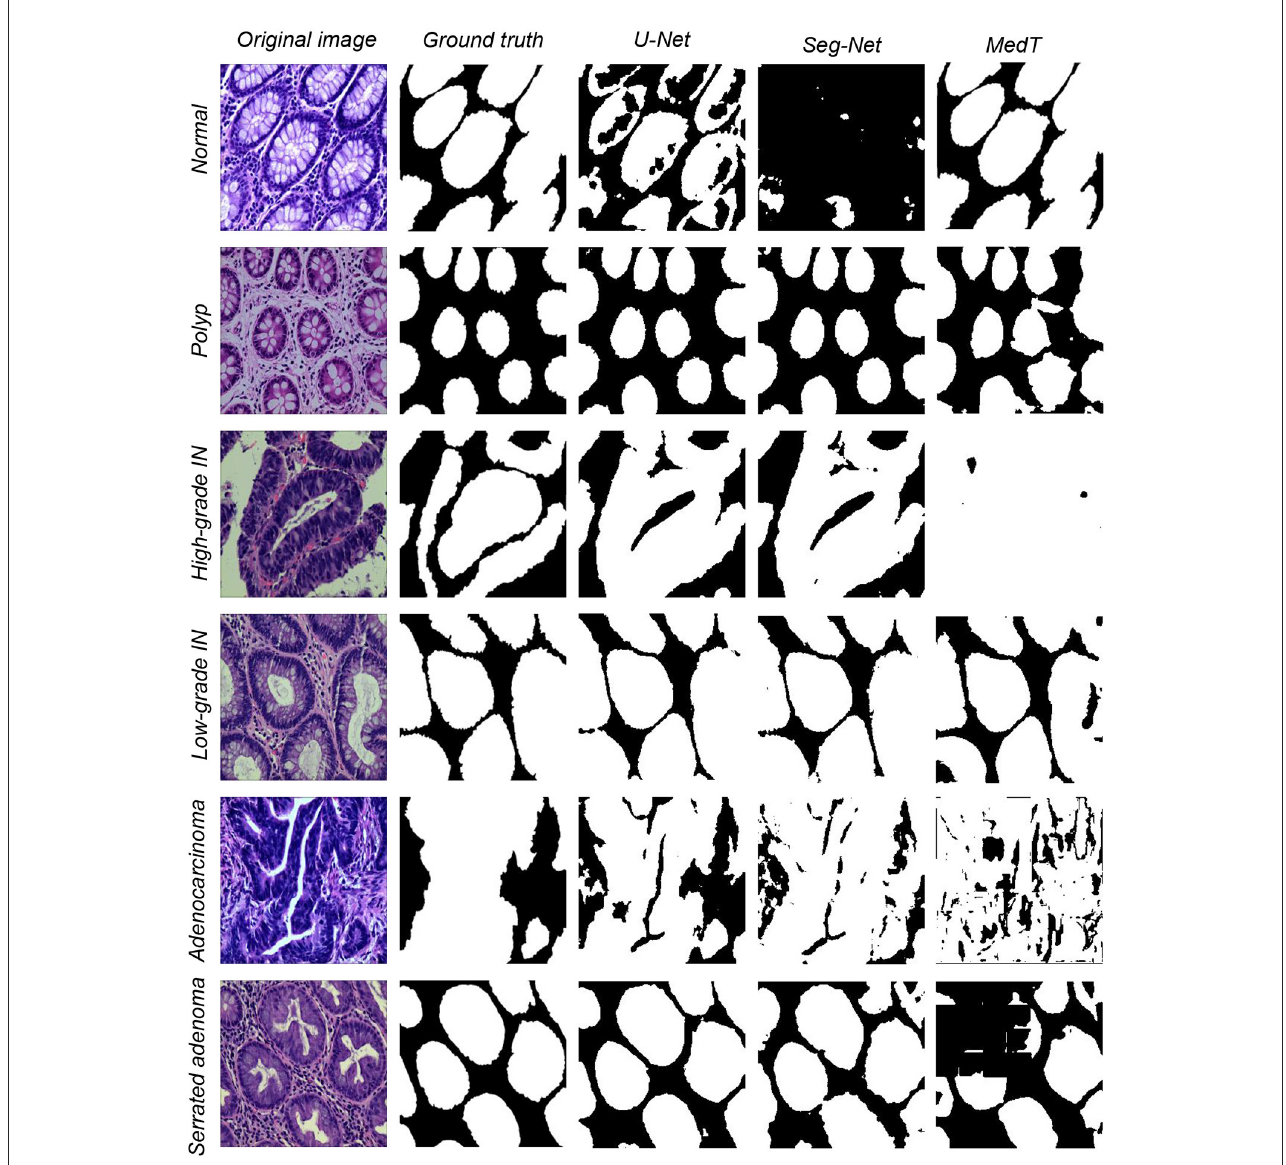
FIGURE3 Three types of data segmentation results obtained by different deep learning